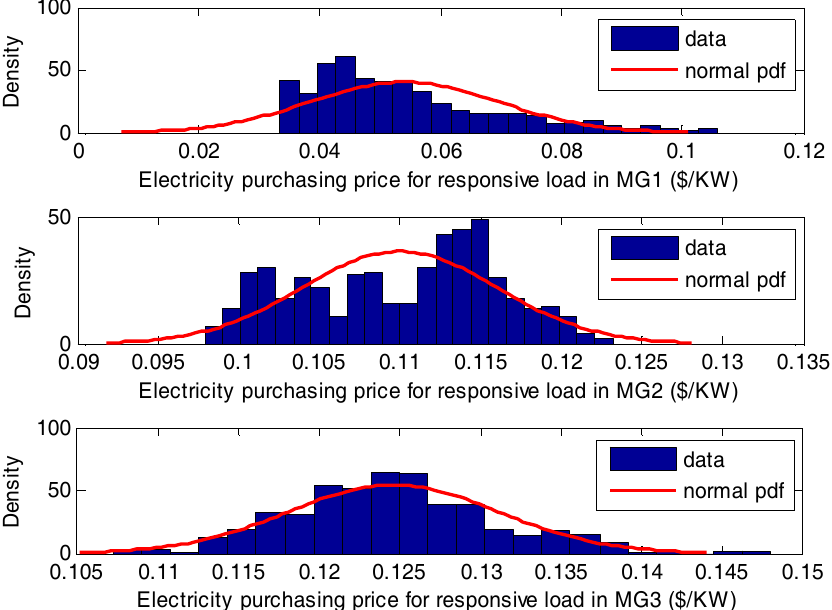
Figure 11. PDF of final energy price of electrical responsive load. Top: MCMG1; Middle: MCMG2, Bottom: MCMG3.